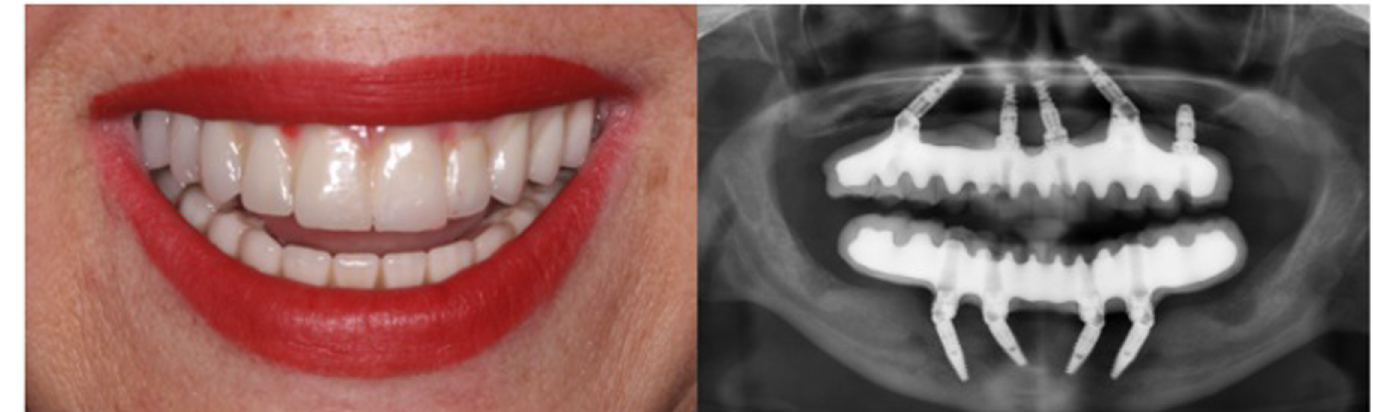
Fig 6. Post-operative views. Final view of the subject (right), and panoramic x-ray (left).